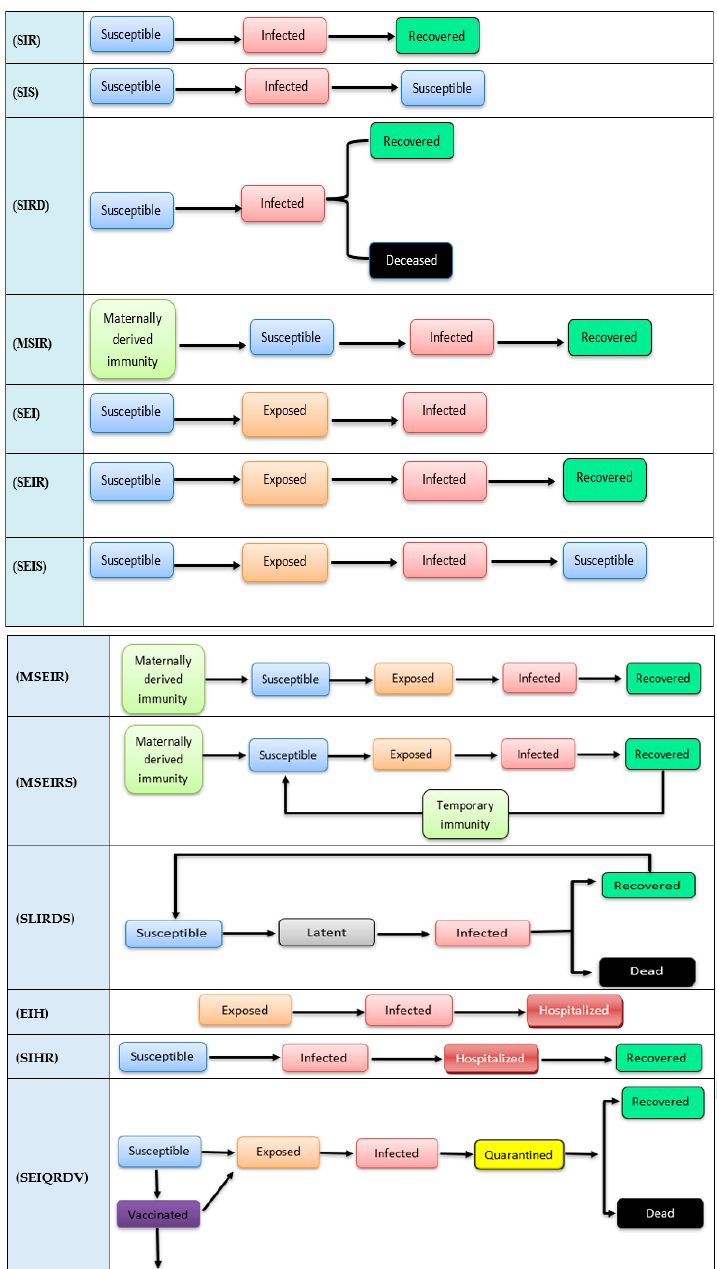
Figure 1. SIR and twelve of its descendant models.